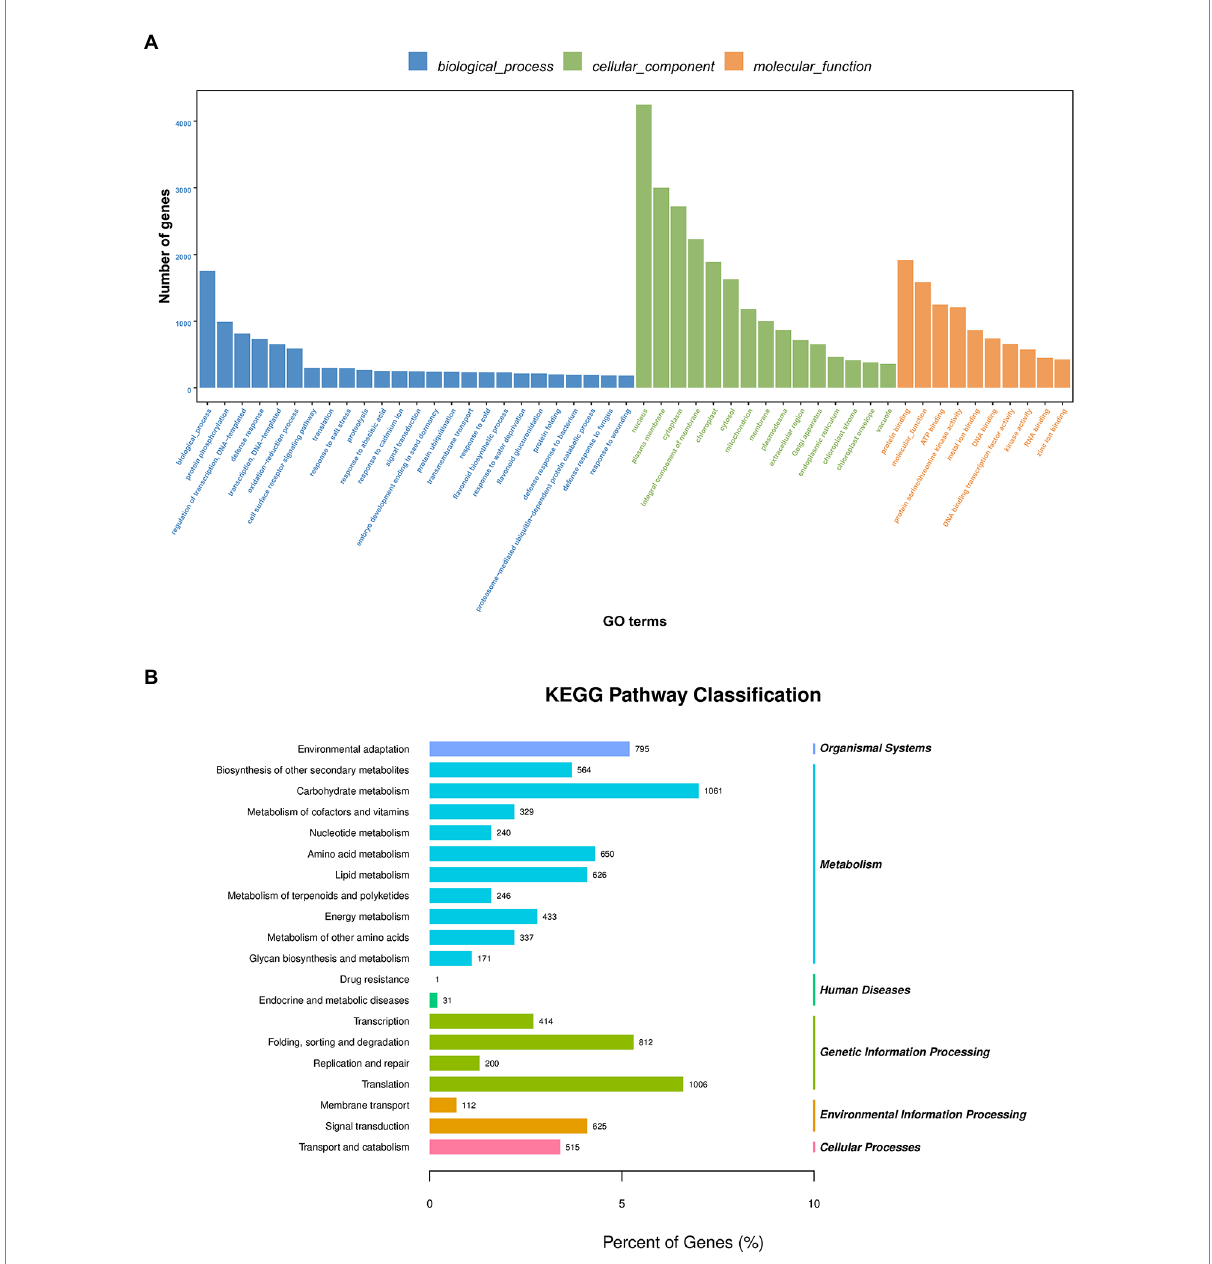
FIGURE 1 GO classification (A) and KEGG pathway enrichment (B) of UniGenes. GO, Gene Ontology; KEGG, Kyoto Encyclopedia of Genes and